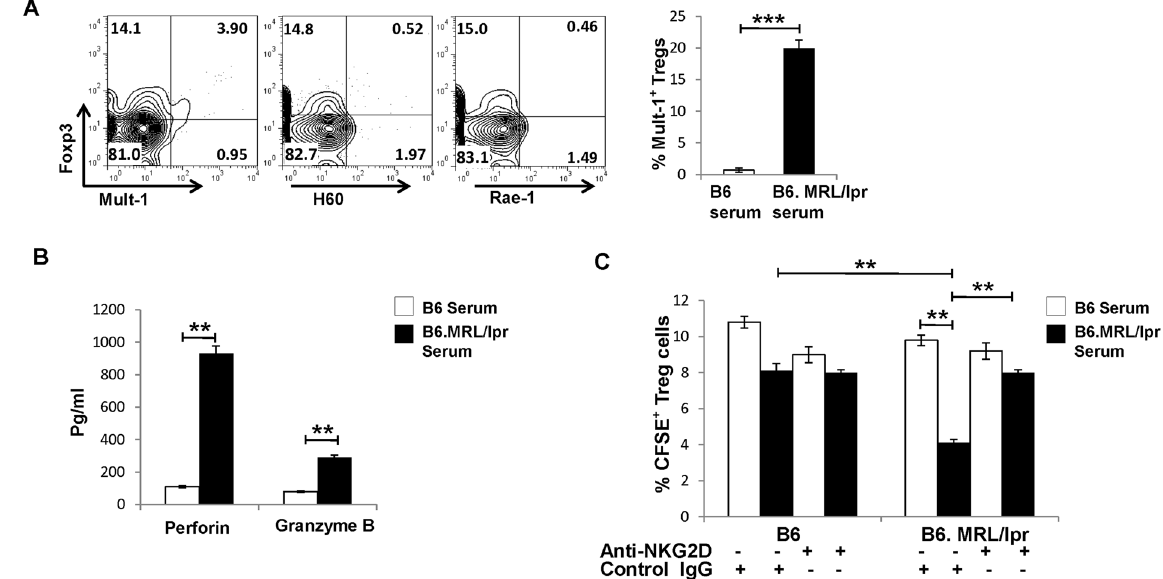
Figure 4. NKG2D + CD4 + T cells killed NKG2DLs-expressing Treg cells in B6.MRL/lpr lupus mice. ( A ) Induction of NKG2DLs expression on mouse Treg cells by lupus mouse serum. Treg cells isolated from the spleens of C57BL/6 (B6) mice were stimulated with B6 or B6.MRL/lpr lupus mouse serum and then assessed by FCM. Data (left) shown are representative of results from lupus mouse serum. Bar graphs (right) are the statistical results obtained from three independent experiments conducted with 3–5 mice. Numbers represent percentages. ( B ) Treg cells isolated from the spleens of B6 mice were stimulated with serum from B6 control mice or from B6.MRL/lpr lupus mice and then co-cultured for 6–8 h with NKG2D + CD4 + T cells from B6.MRL/ lpr lupus mice. Supernatants were assessed by ELISA. Bar graphs present the statistical results obtained from three independent experiments with Treg cells and NKG2D + CD4 + T cells. ( C ) CFSE-labeled Treg cells from B6 mice were stimulated in vitro with B6 serum or MRL/lpr mouse serum and transferred to B6 mice and B6.MRL/ lpr mice, with or without indicated antibodies pre-treatment, respectively, and the frequency of exogenous Treg cells was examined in gated CD4 + T cells by FCM. Data represent three independent experiments with 3–5 mice. Horizontal lines with vertical bar borders show the mean ± SD. ** P < 0.01, *** P <